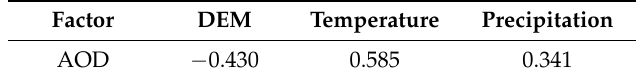
Table 3. Coefficient between AOD and the environmental impact